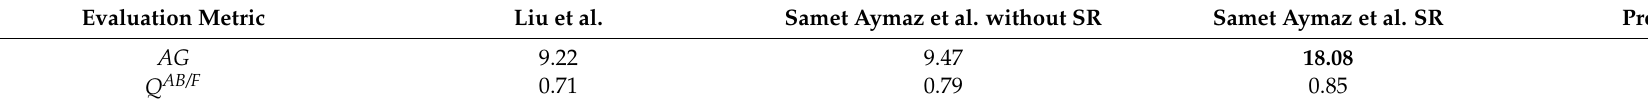
Table 23. The outcomes for the flower image and comparisons with existing techniques in the literature ([24]).